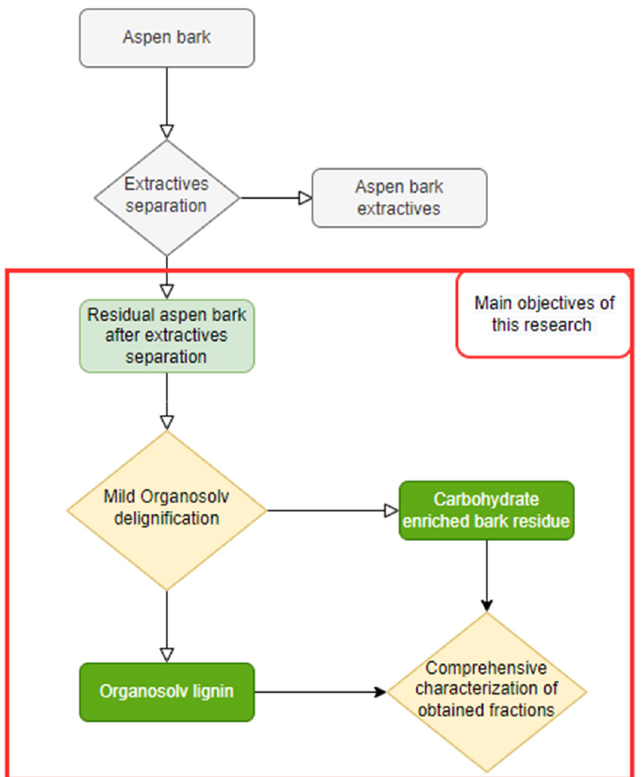
Figure 2. Process diagram of the workflow for the biorefinery approach for valorization of aspen bark.